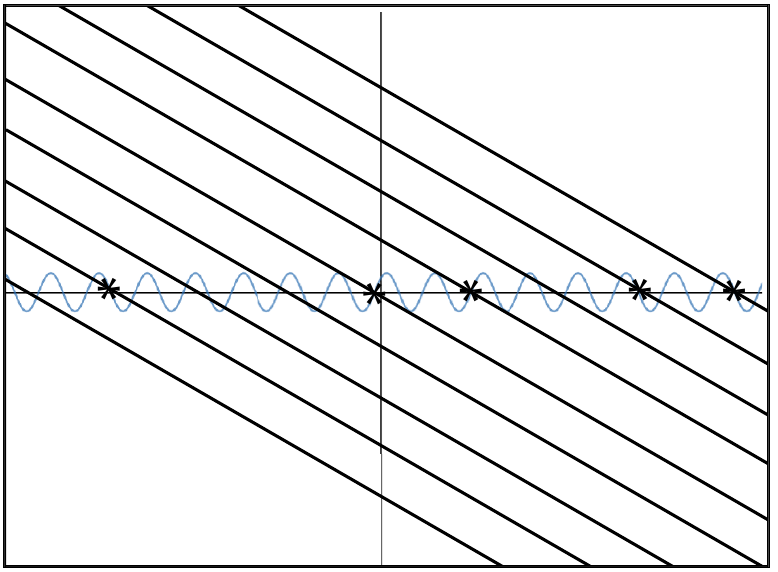
Figure 1 . Vacua are given by the intersections of the lines and the sine (3.21). For simplicity we took V to be the quadratic monodromy here. The asterisks denote the vacua with very small residual cosmological constant due to ωφ/ cosmological constant is small in any intersection. figure 1. The resulting picture is the structure of vacua with a range of residual